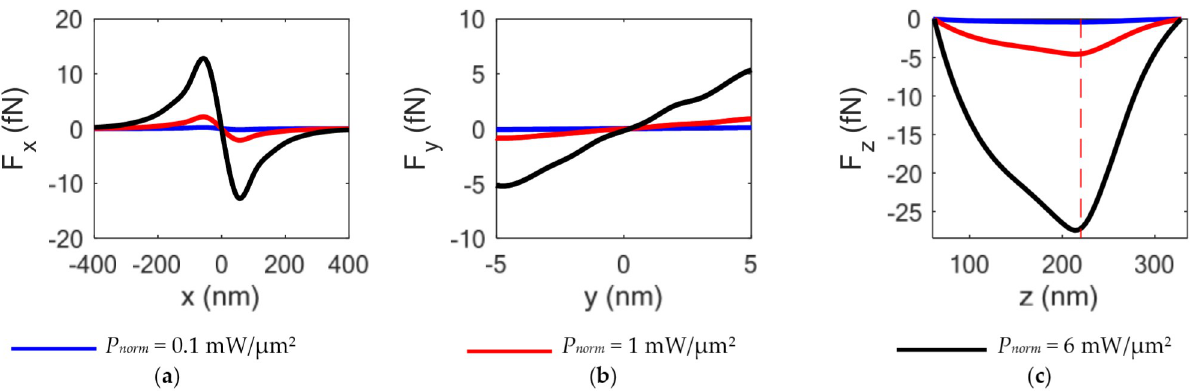
Figure 4. Lateral view of the nanocavity (z–y directions) with a trapped particle ( d = 100 nm).